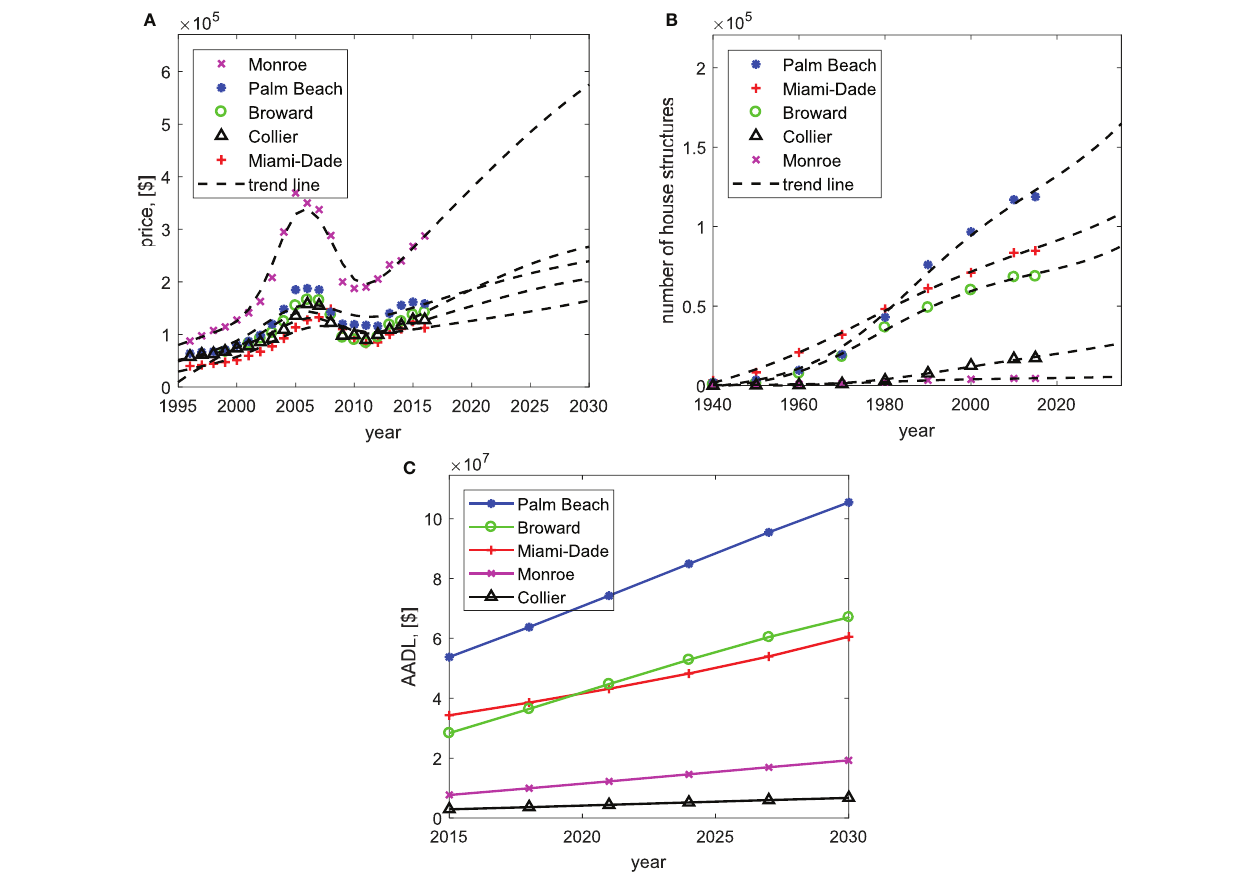
FigUre 10 | Predicted changes of: (a) the average building price (without the price of the lot) between 1995 and 2030, (B) the number wood-frame residential structures with a gable roof between 1940 and 2030, (c) the average annual dollar loss between 2015 and